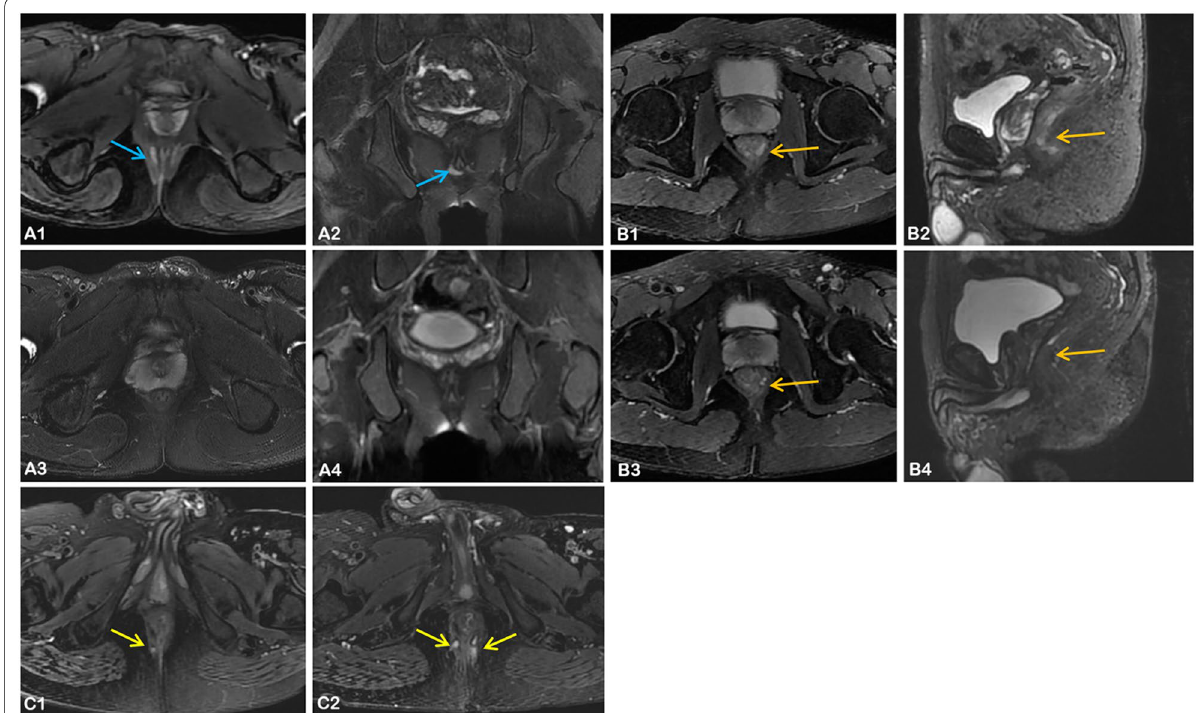
Fig. 4 Comparison of baseline and follow-up MRI in three patients with Crohn’s disease. A1 – A4 Axial and coronal T2-weighted images of a 22-year-old male from the high activity group, in which a high-signal perianal fistula is visible in baseline images ( A1 , A2 ), and after 15 months of treatment with adalimumab, the corresponding lesion disappeared in follow-up images ( A3 , A4 ); B1 – B4 Axial and sagittal T2-weighted images of a 29-year-old male from the low-activity group, where the high T2 signal lesion in baseline images ( B1 , B2 ) was significantly reduced in extent in follow-up images ( B3 , B4 ) after 3 months of treatment with vedolizumab; C1 , C2 Axial T2-weighted images of a 34-year-old male from the low-activity group, where a high T2 signal fistula in baseline image ( C1 ) became significantly more extensive in follow-up image ( C2 ) and